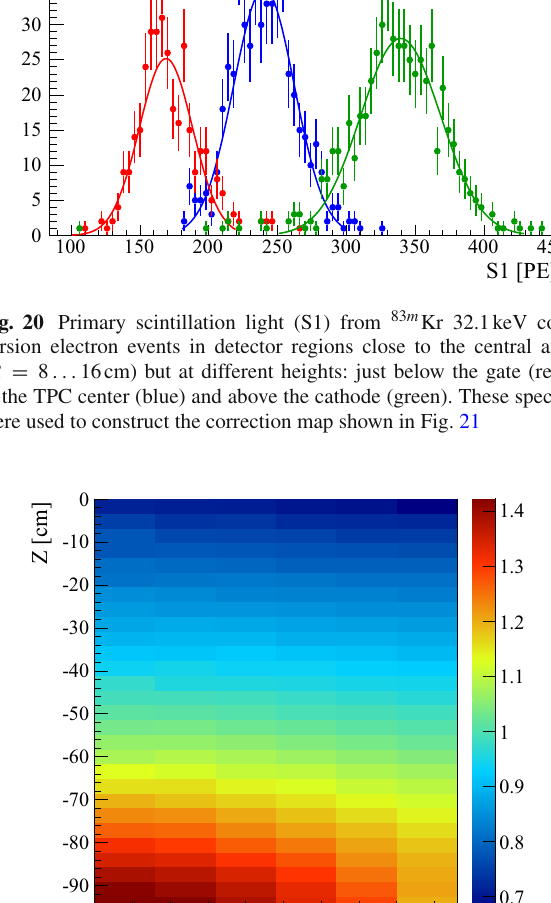
PMTs. A small dependence on the azimuth-angle φ is taken